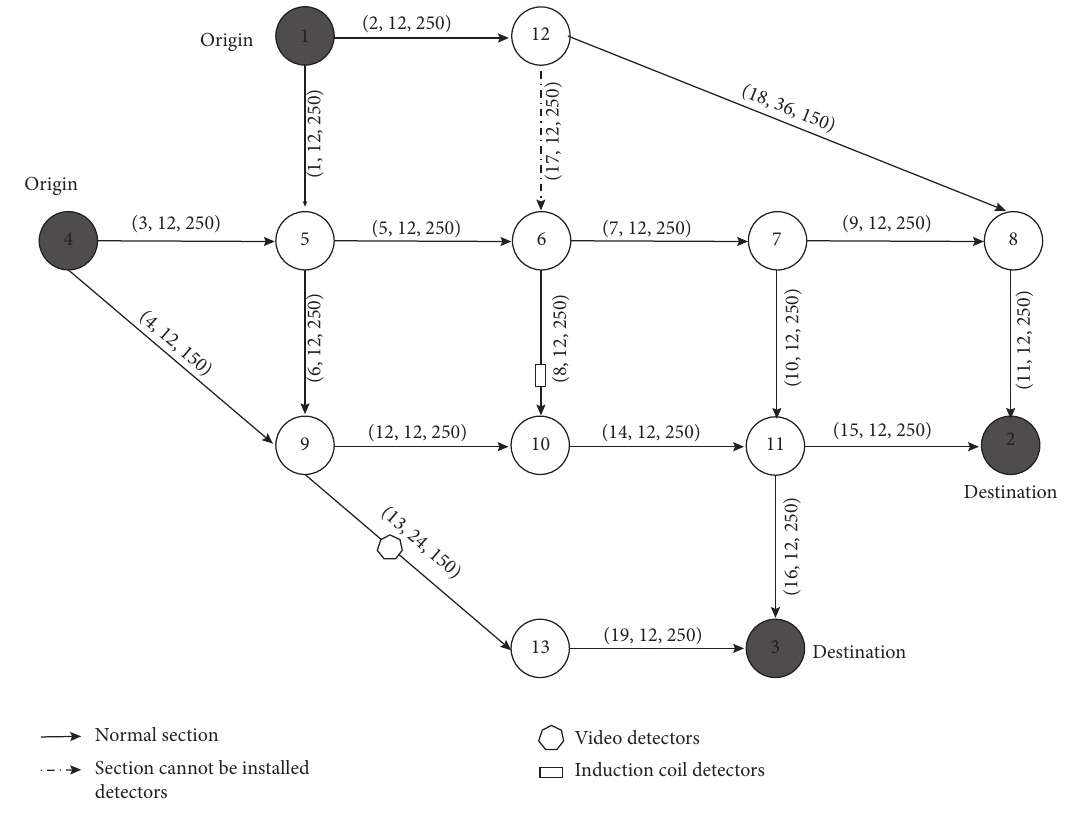
Figure 1: Nguyen–Dupuis network. Table 2: OD traffic demand. Table 3: Effective path sets and